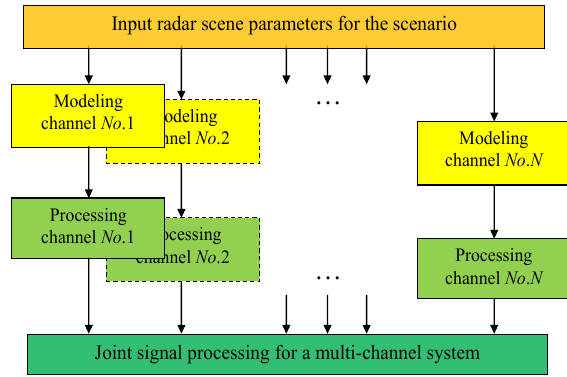
Fig. 2. The general structure of the multi-channel version of the modelling